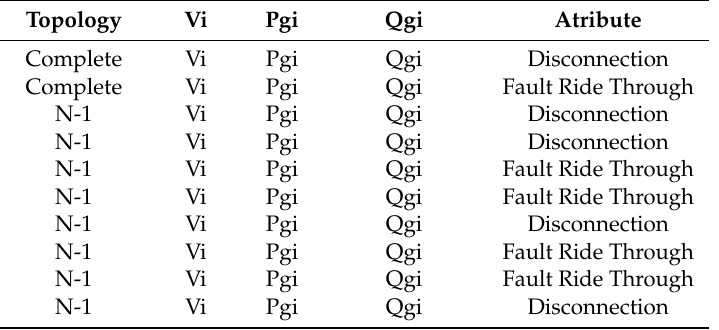
Table 2. Local database